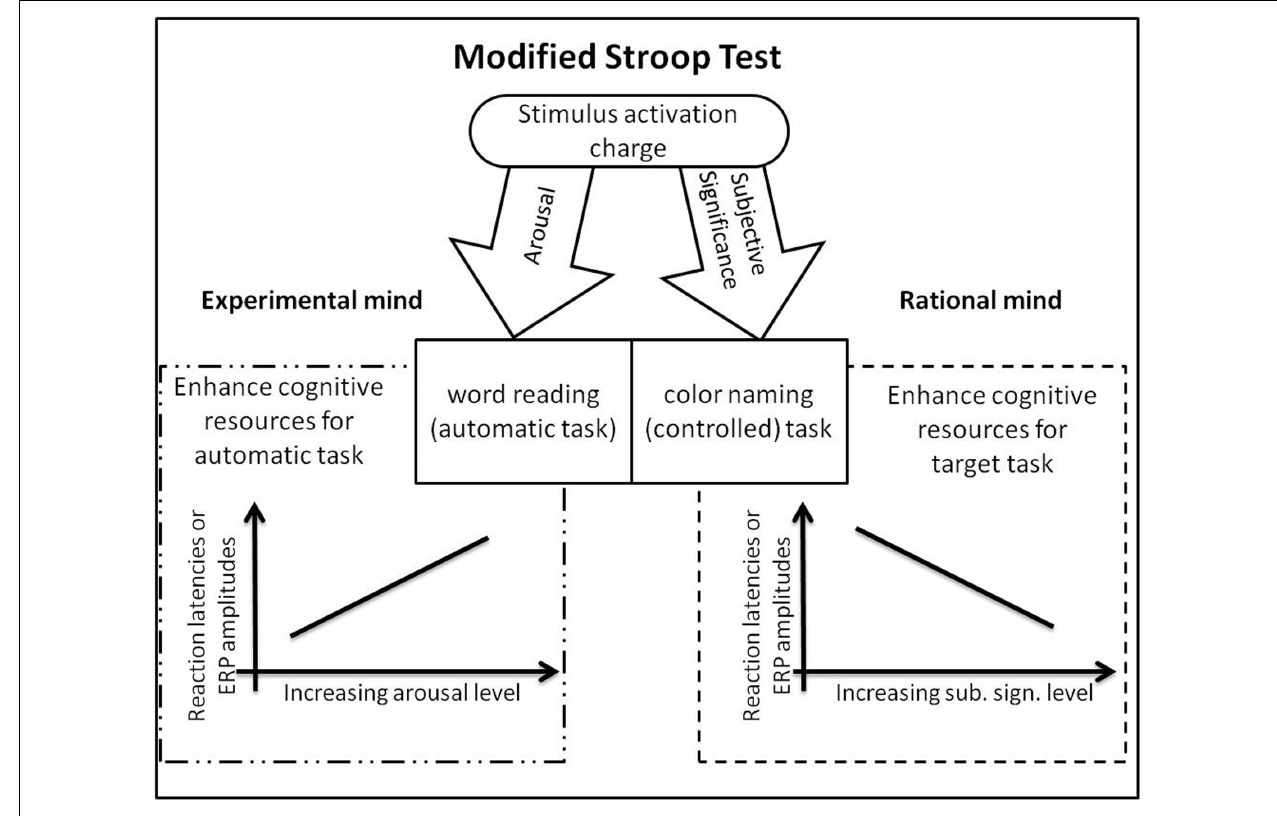
FIGURE 1 | Activational properties of stimuli (arousal and significance) and their influence on Stroop task components and behavior (Imbir,